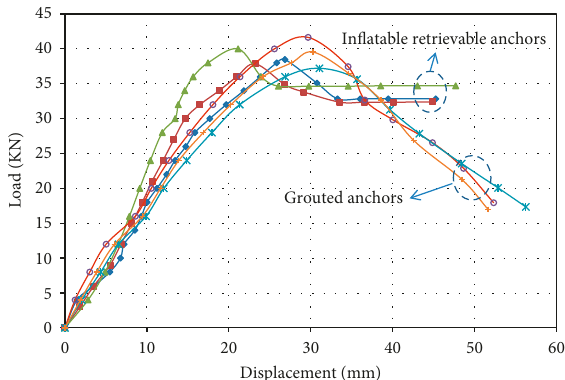
Figure 13: Pullout force versus displacement between inflatable retrievable anchors and grouted anchors.